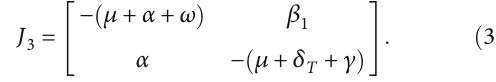
= 0 : 01 , α = 0 : 632 , ω = T = 2 : 263 > 1 0